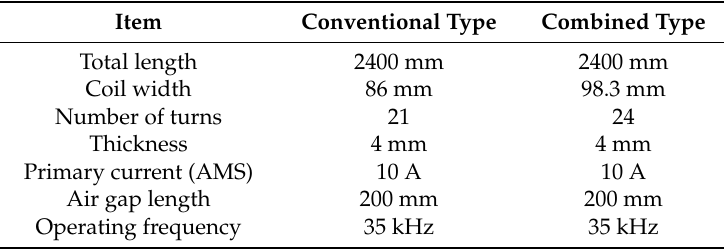
Table 2. Design specifications of transmitting coils for EV dynamic